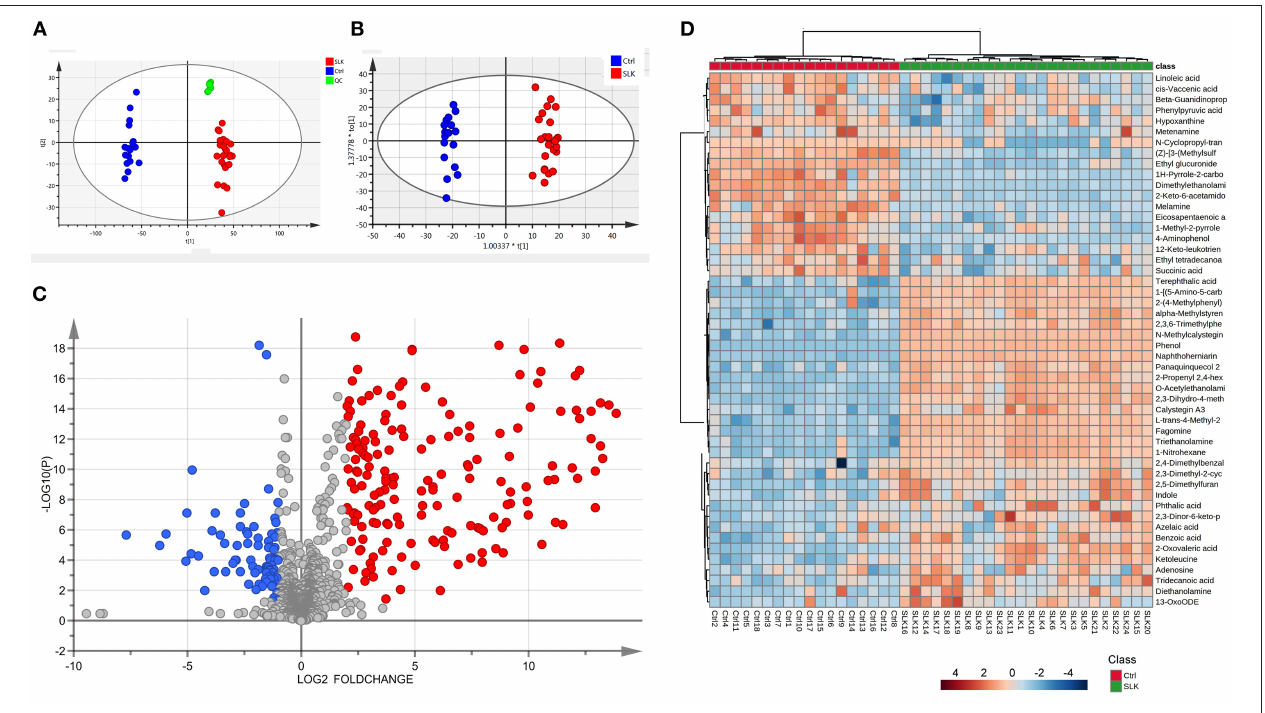
FIGURE 1 | Metabolomics analysis of tear samples from patients with superior limbic keratoconjunctivitis (SLK) compared with the controls (Ctrl). (A) Principal component analysis (PCA) score plots of Ctrl (blue), SLK (red), and quality control (QC, green). The X-axis (t[1]) and Y-axis (t[2]) indicate the first and second principal components, respectively. (B) Orthogonal projections to latent structures-discriminate analysis (OPLS-DA) score plots for the Ctrl (blue) and SLK (red) groups. The X-axis (t[1]) and Y-axis (to[1]) indicate the predictive and orthogonal directions, respectively. (C) Volcano plots highlighting the tear metabolites that increased (red) or decreased (blue) in SLK tear fluids compared to the control group, with p < 0.05, log 2 FC > 1 or < -1. (D) Hierarchical cluster analysis and heatmap of the differentially expressed metabolites from the SLK and Ctrl groups. The color code in the heatmap represents the relative metabolite abundance: red and blue colors indicate increased and decreased levels of each metabolite in the SLK group versus the Ctrl group,